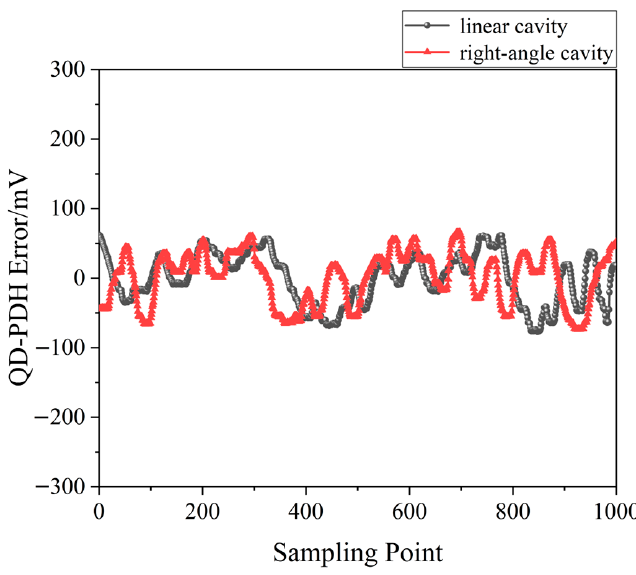
Figure 40. Error signals of the frequency-locked QD-PDH subsystems [43].